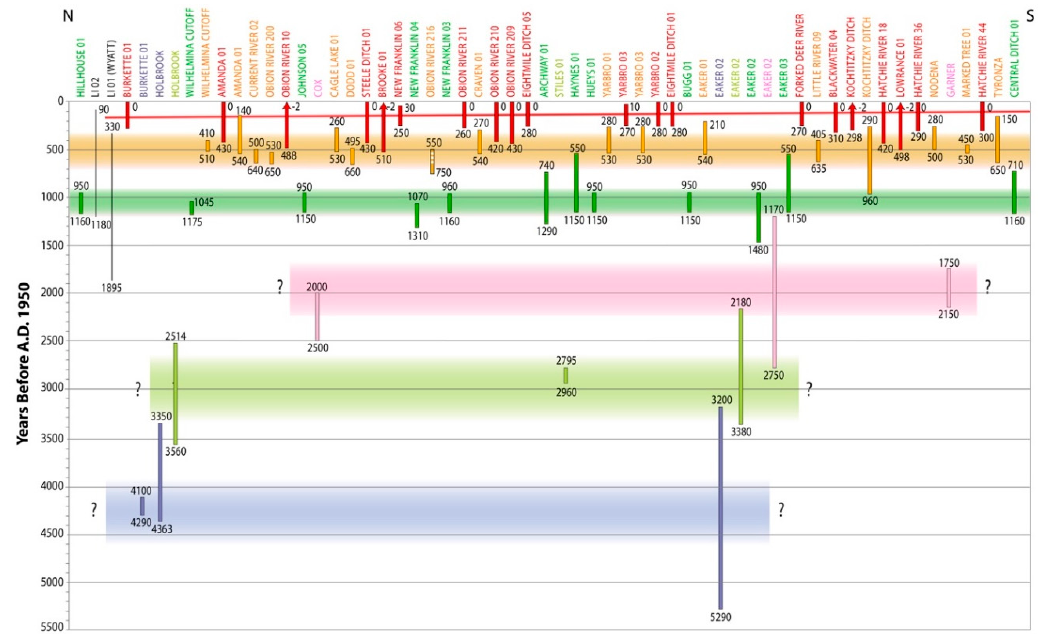
Figure 29. Diagram illustrating earthquake chronology of New Madrid seismic zone for past 5500 years based on dating and correlation of liquefaction features at sites (listed at top) across region from northeast to southwest. Vertical bars represent age estimates of individual sand blows, and horizontal bars represent event times of AD 1811–1812 (138 years BP); AD 1450 ± 150 years (500 years BP); AD 900 ± 100 years (1050 years BP); AD 0 ± 200 years (1950 years BP), BC 1050 ± 250 years (3000 years BP), and BC 2350 ± 200 years (4300 years BP) (modified from References [8,51]).